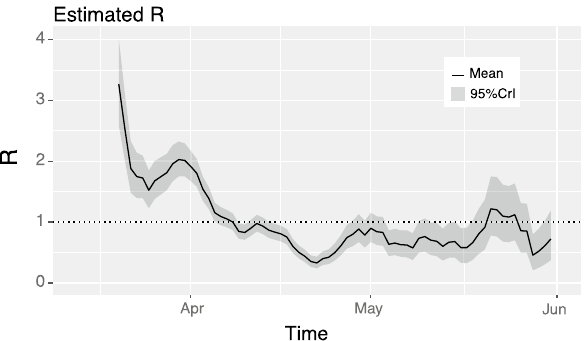
Figure 12. Estimation of R t based on the methodology of 28 together with 95% confidence (green curve) intervals. The plot is based on weekly data and on choosing the serial interval distribution to be Gamma with mean 6.48 days and standard deviation of 3.83; see 29 for